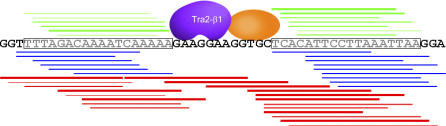
Schematic Diagram of the In Vivo Effects of All Tested ASOs on Exon 7 InclusionAn essential core sequence (in bold) surrounded by two inhibitory regions, A and B (boxed), in SMN2 exon 7. Horizontal bars represent ASOs with stimulatory effects (green), inhibitory effects (red), or neutral effects (blue). The thicker the bars, the stronger the effects. Tra2β1 and another putative activator are shown bound to the central core region.